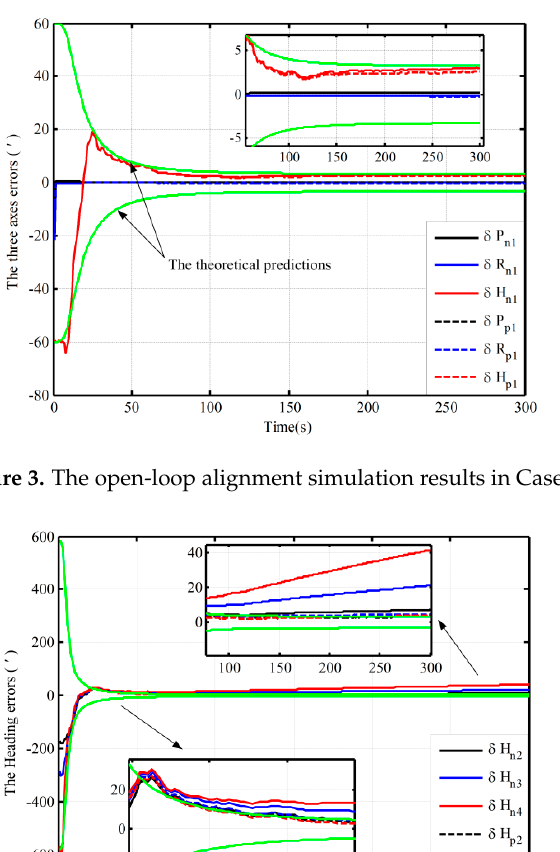
Table 1. The different initial conditions for the open-loop KF.